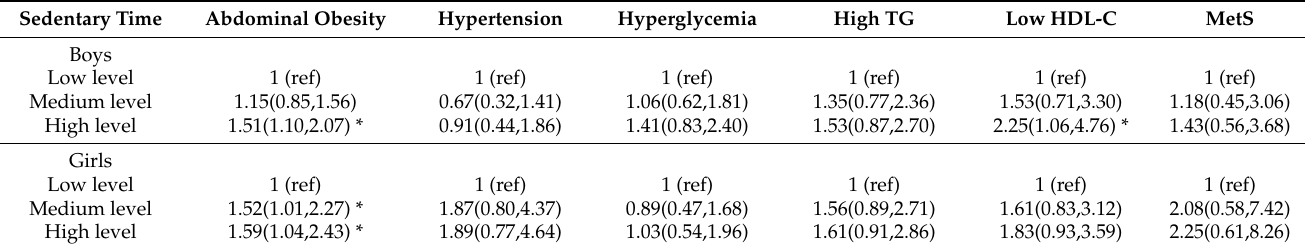
Table 4. Logistic regression analysis of sedentary behavior time, MetS, and its components of children aged 6–14 years by gender # (OR (95% CI of